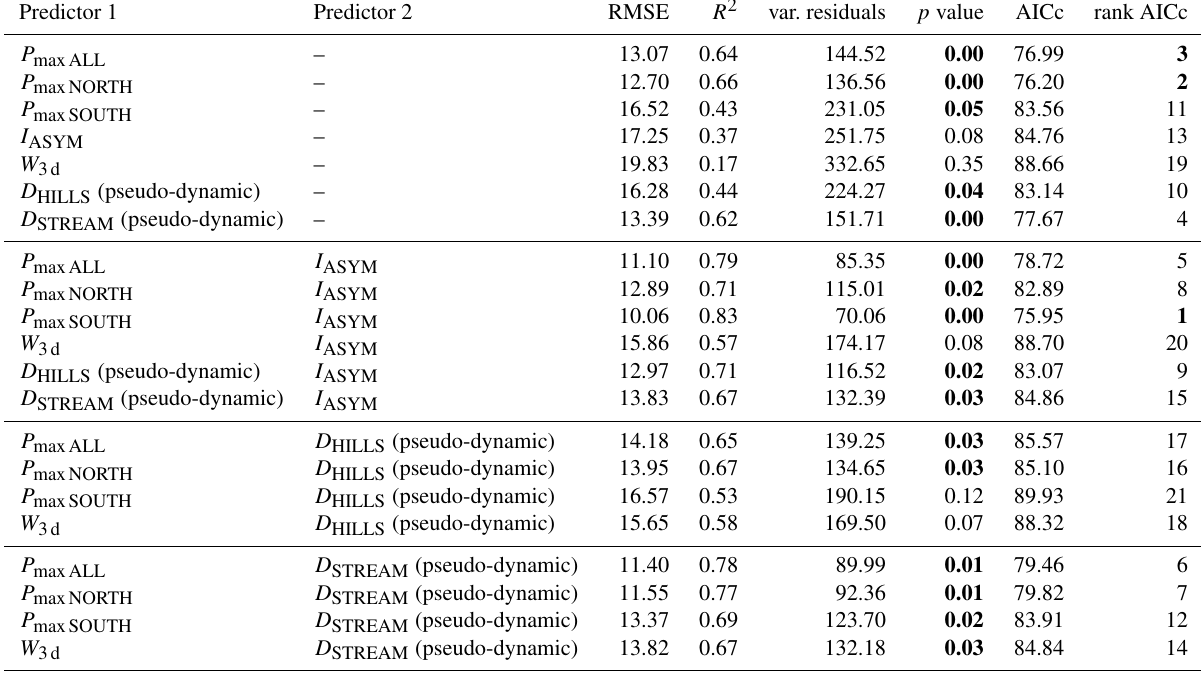
Table 7. As in Table 6 but for the lag (cid:49) P/Q